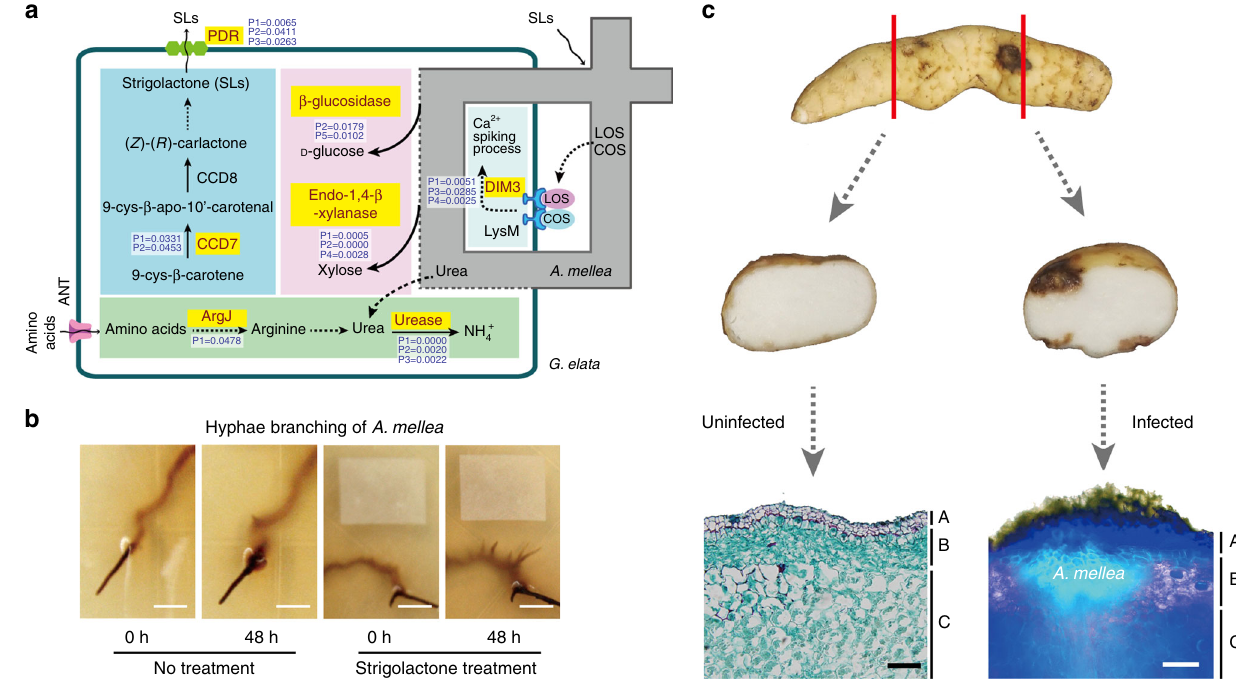
Fig. 3 Strigolactone as a putative signal compound in G . elata in its mycoheterotrophic symbiotic relationship with A . mellea . a Overview of proposed signaling and nutrition transfer in G . elata . The red-labeled genes are expanded in the G . elata genome and P -value of Fisher ’ s exact test of gene number <0.05 (Supplementary Tables 38, 40, 41). ANT, ANT1-like aromatic and neutral amino acid transporters; ArgJ, glutamate N-acetyltransferase; CCD, carotenoid cleavage dioxygenases; COS, chitooligosaccharides; DMI3, does-not-make-infections 3 subfamily; LOS, lipochitooligosaccharides; LysM, LysM- receptor-like kinases; PDR, ABC transporter. P1, p -value of Fisher ’ s exact test of gene number in G . elata genome compared to P . equestris , D . of fi cinale , A . comosus , and A . thaliana ; P2, p -value of Fisher ’ s exact test of gene number in G . elata genome compared to A . thaliana ; P3, p -value of Fisher ’ s exact test of gene number in G . elata genome compared to A . comosus ; P5, p -value of Fisher ’ s exact test of gene number in G . elata , P . equestris , and D . of fi cinale genome compared to A . comosus and A . thaliana . b Branching of A . mellea hyphae was signi fi cantly promoted after strigolactone treatment (Supplementary Fig. 13). Scale bar was 5 mm. c Cross sections and micrographs of immature G . elata tubers in association with A . mellea (A, epidermis; B, cortex; C, inner parenchyma cells, Supplementary Fig. 14). The black scale bar on the left was 100 μ m and the white one on the right was 20 μ